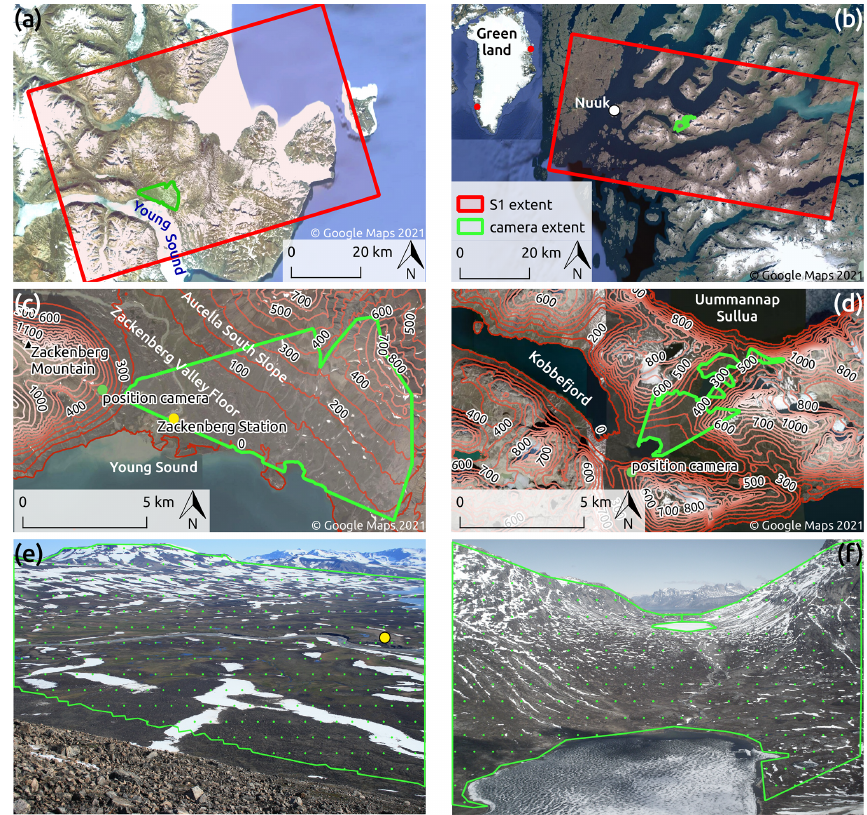
Figure 2. (a, b) Overview of the Zackenberg/Kobbefjord study area and Sentinel-1 scene located in northeastern/southwestern Greenland (see red dots in inlet of panel b ). (c, d) Study sites of Zackenberg (c) and Kobbefjord (d) with camera field of view and location of time-lapse camera (green dot) and Zackenberg research station (yellow dot) in panel (c) . (e) Master image of time-lapse camera with used field of view and location of Zackenberg research station (yellow dot). Background image from GeoBasis Zackenberg (Greenland Ecosystem Monitor- ing Secretariat, 2021). (f) Master image of Kobbefjord study area. Background image from GeoBasis Kobbefjord (Greenland Ecosystem Monitoring Secretariat, 2021).